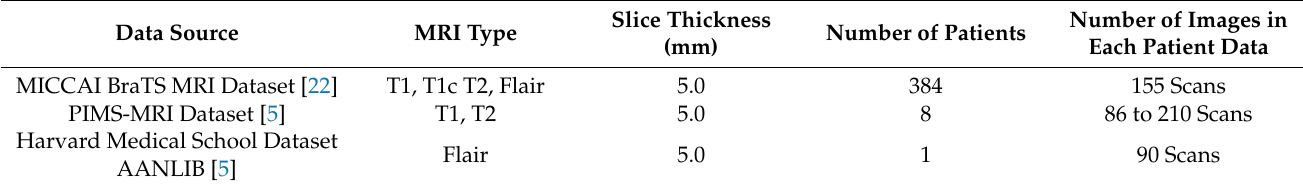
Table 1. Brain MRI Dataset